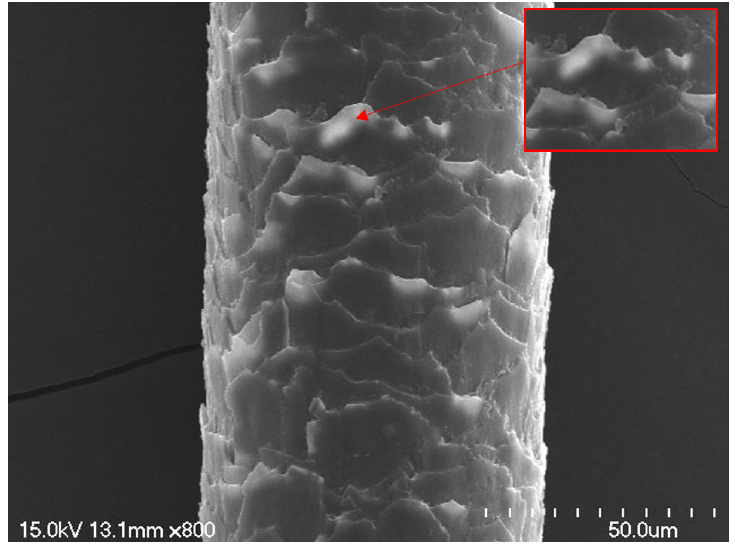
Figure 1. Scanning electron microscope (SEM) imaging to observe hair magnification 800×